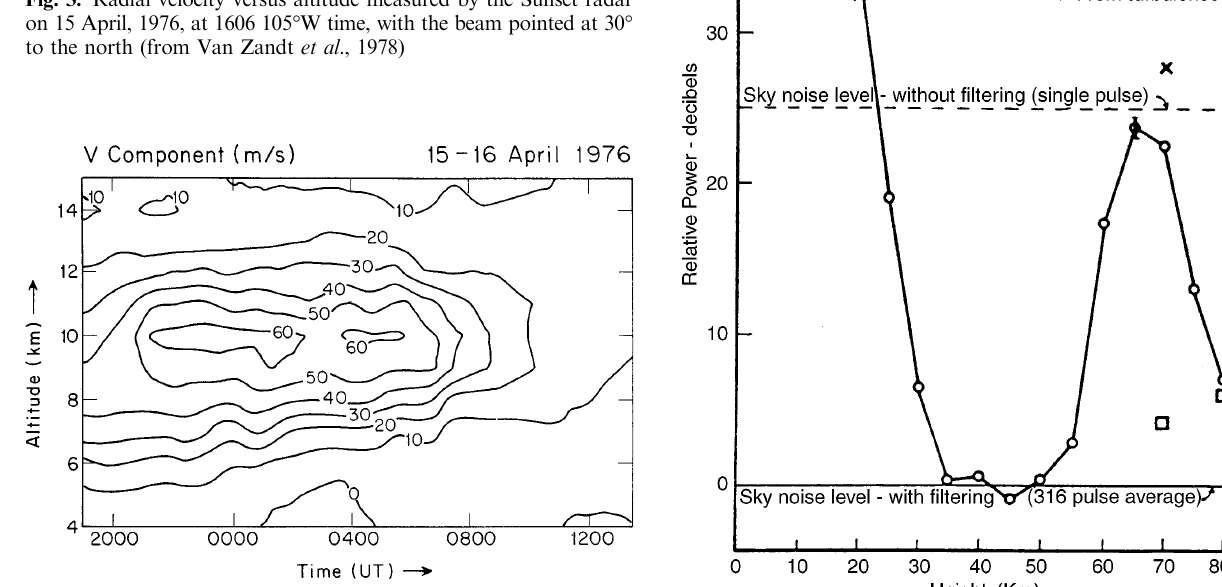
Fig. 4. Time-height cross section of the meridional wind measured by the Sunset radar on 15–16 April 1976 during the passage of a polar- front jet stream (from Green et al ., 1978)